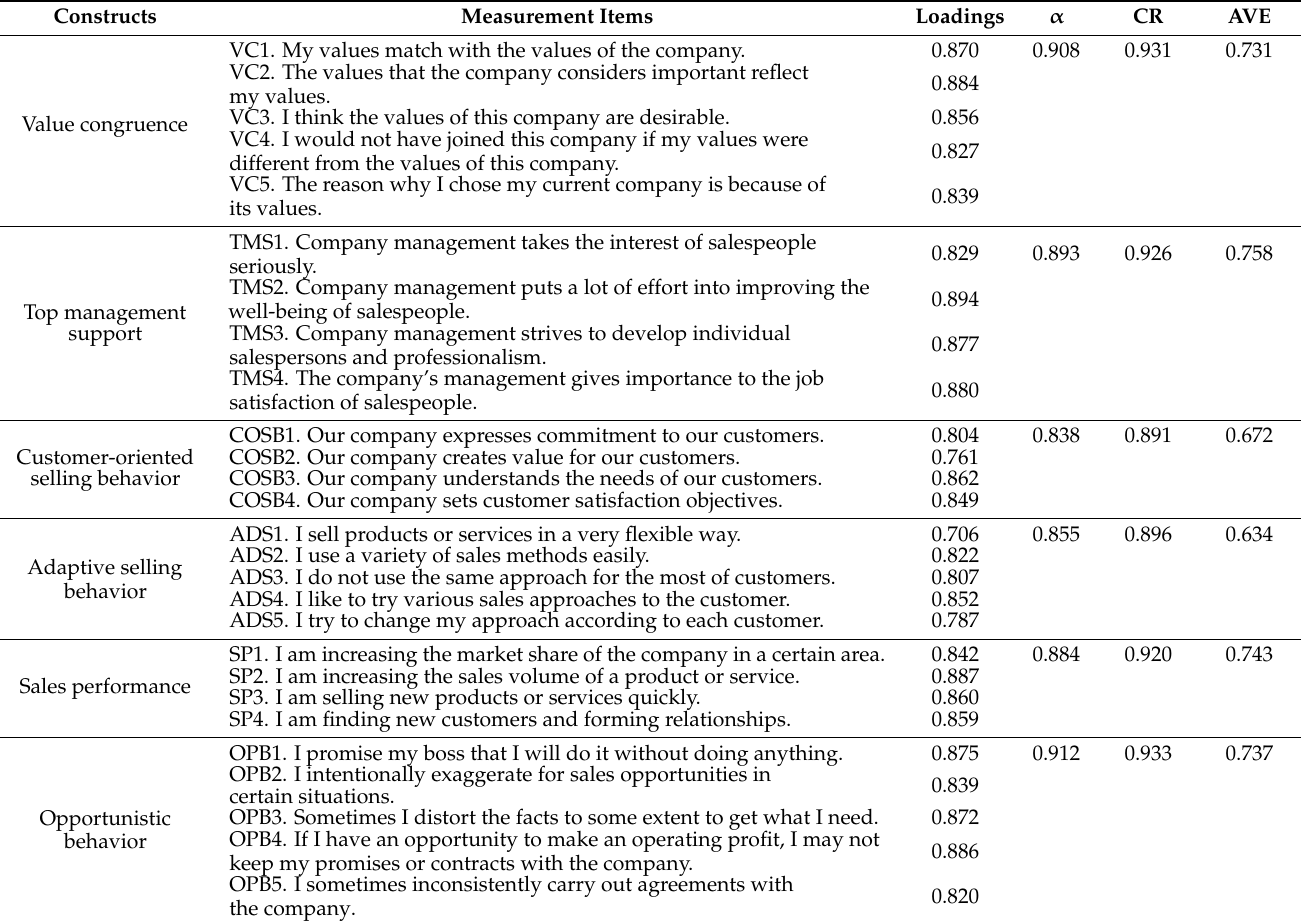
Table 3. Measurement items and the results of confirmatory factor analysis.